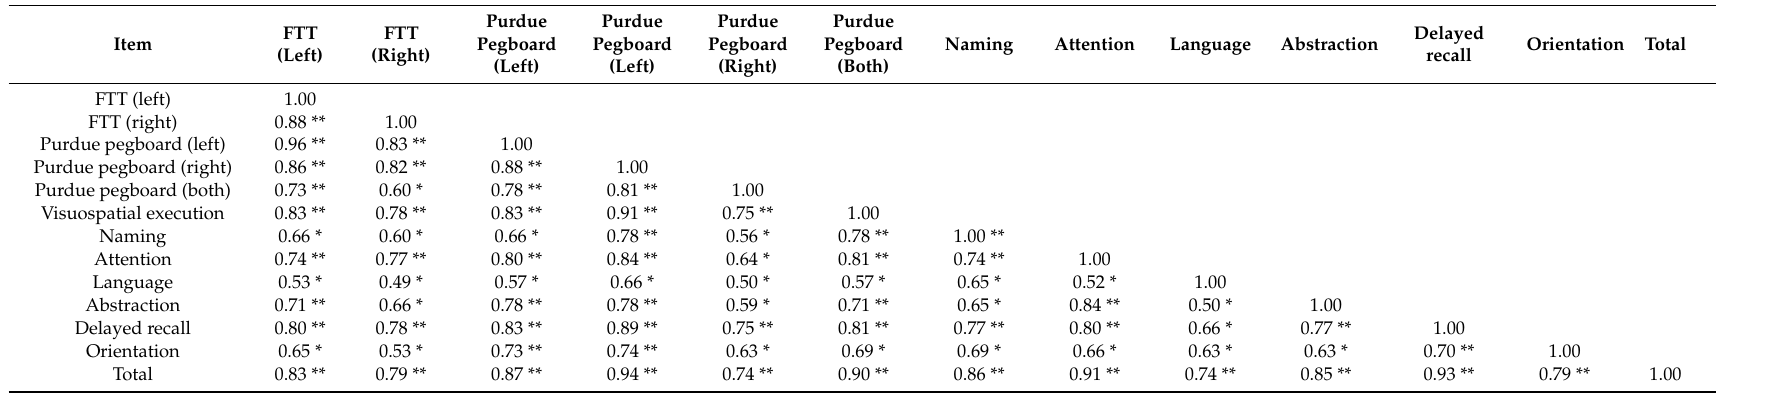
Table 5. Correlation analysis on the dimensional and total scores of Finger Tapping Test (FTT), Purdue Pegboard Test (PPT), and Montreal Cognitive Assessment